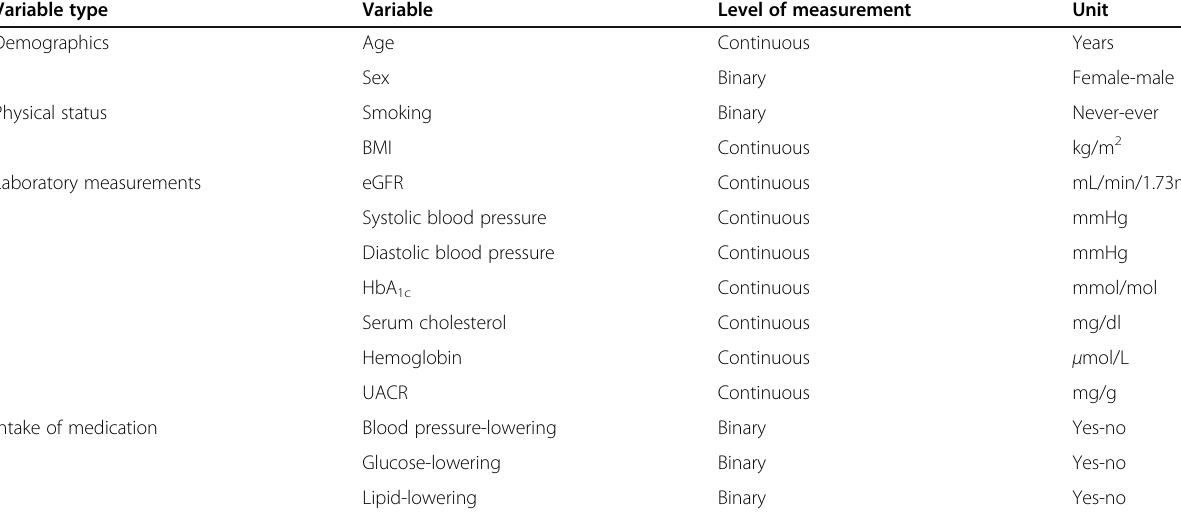
Table 2 Clinical baseline information of study participants within PROVALID, GCKD, and DIACORE Variable